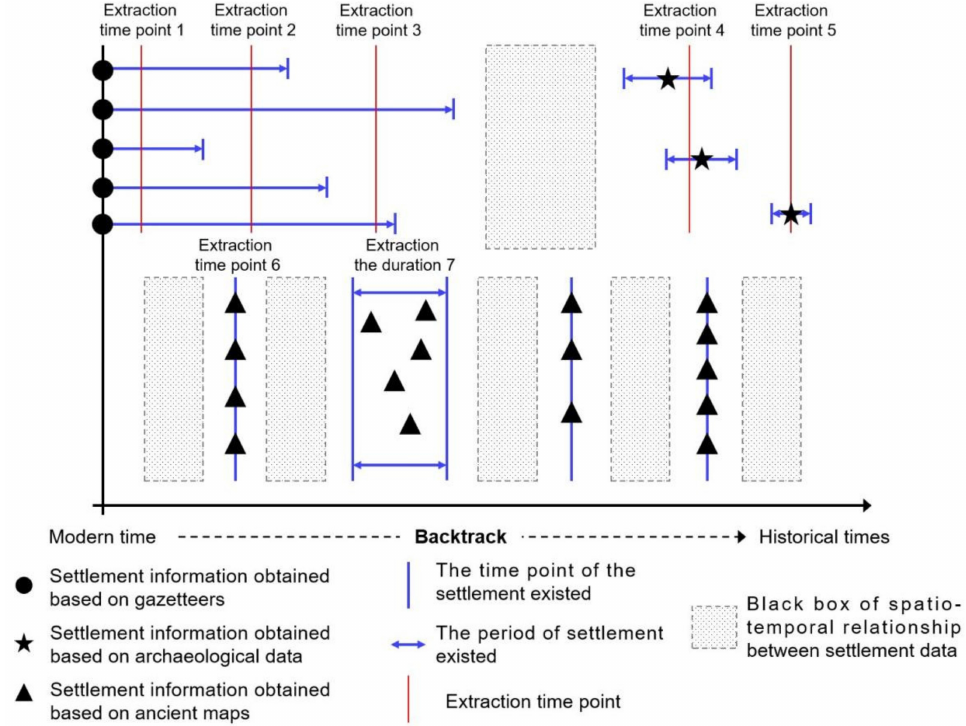
Figure 11. Records and characteristics of the three main kinds of historical settlement information. Gazetteers, usually in the form of books, contain records of the names, origin, evolution, and geographical locations of modern existing cities, towns, and villages in a particular